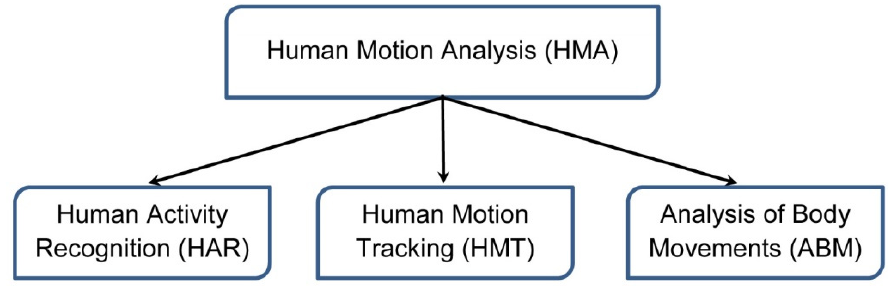
Figure 1. Categories of human motion analysis.